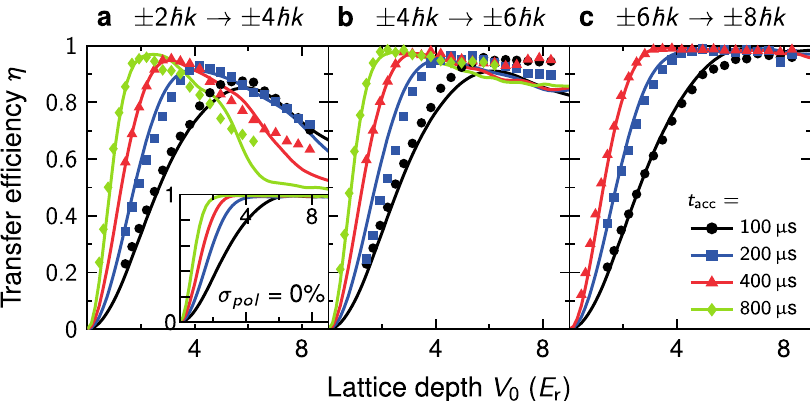
Fig. 5 Bloch transfer ef fi ciency in the twin lattice. Ef fi ciency of one BO exerted by our twin lattice in dependence of the initial state. A superposition of BECs with momenta ( a ) ±2 ℏ k , ( b ) ±4 ℏ k , or ( c ) ±6 ℏ k created via fi rst-order DBD and sequential Bragg pulses is accelerated via BO acquiring an additional momentum of ±2 ℏ k . The ef fi ciency is recorded for different times t acc and in dependence of the lattice depth V 0 in units of recoil energy E r = ℏ 2 k 2 /(2 m ). In all cases, a larger t acc corresponds to a lower acceleration and reduces nonadiabatic losses as expected from Landau – Zener theory. Our experimental results (symbols) are well reproduced by theoretical simulations (lines) assuming an additional standing lattice of depth 0.37 V 0 arising from polarization imperfections (Supplementary Eq. (2)). The losses caused by the latter decrease with a larger initial splitting K and from ( a ) to ( c ) as the detuning from the standing lattice increases. The inset shows the theoretical ef fi ciency for ideal polarization, that is, a perfect twin lattice, of the transfer ±2 ℏ k → ±4 ℏ k